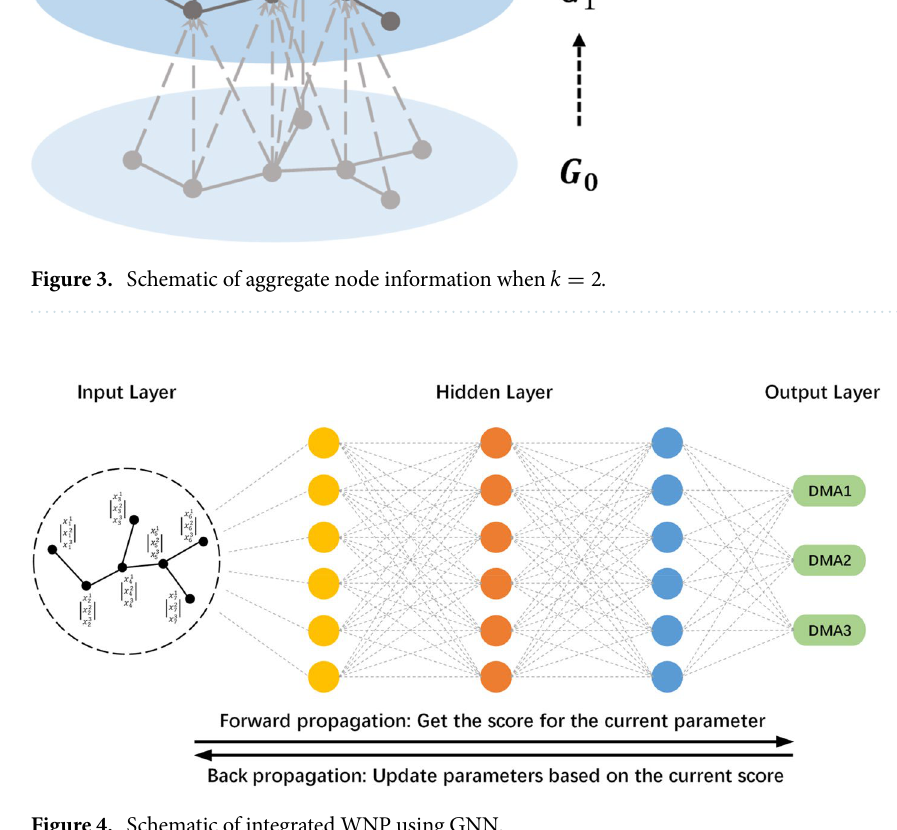
Figure 4. Schematic of integrated WNP using